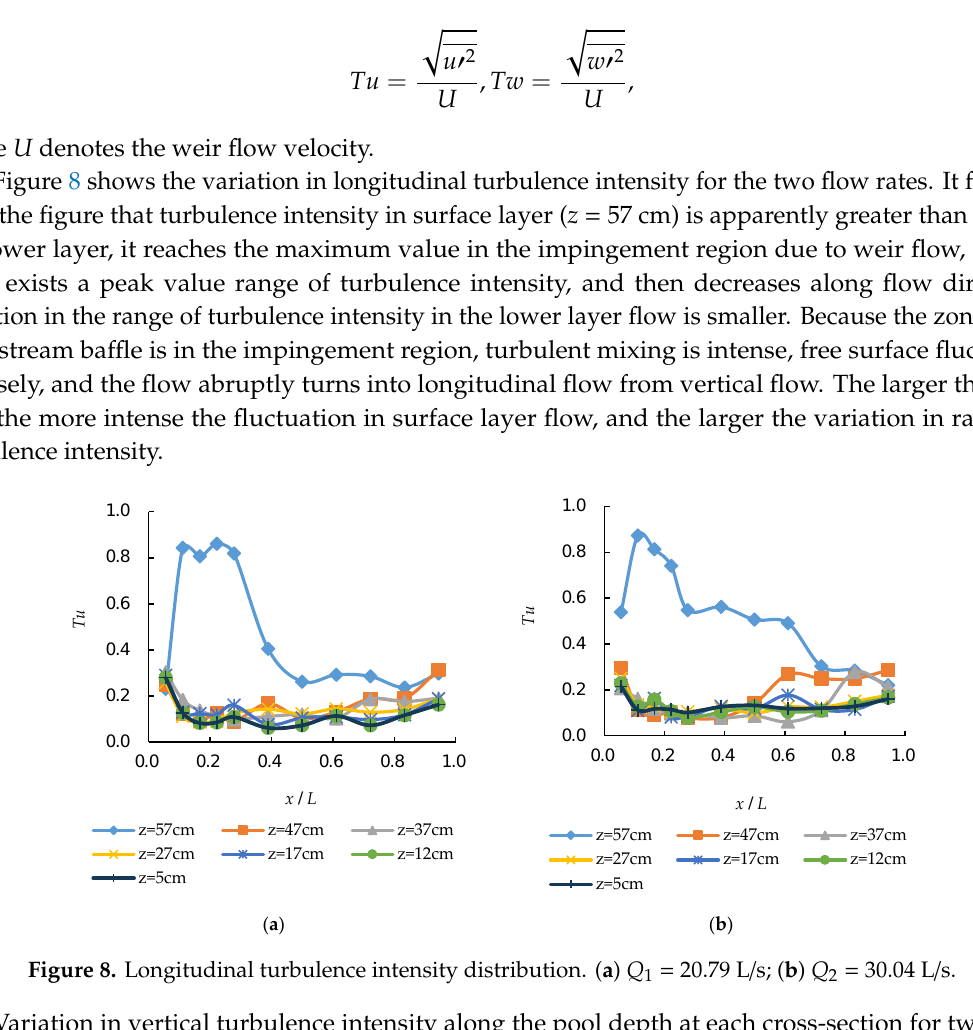
1 = 20.79 L/s; ( b ) Q 2 = 30.04 L/s.